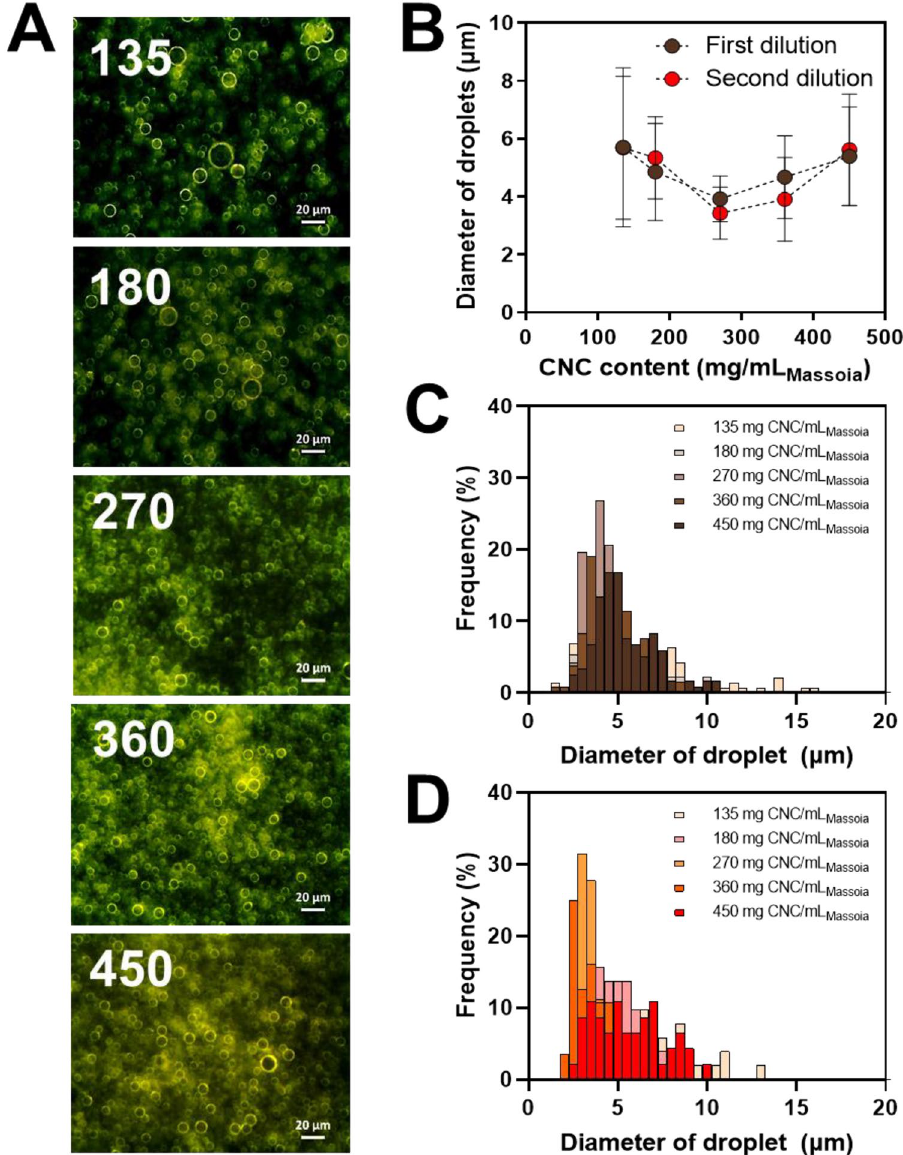
Figure 2. CNC/massoia PEs at different CNC contents. ( A ) Dark-field microscopic images of PE, ( B ) size of emulsion droplets and ( C , D ) size distribution of emulsion droplets. ( C ) First dilution and ( D ) second dilution. N = 300, error bar =